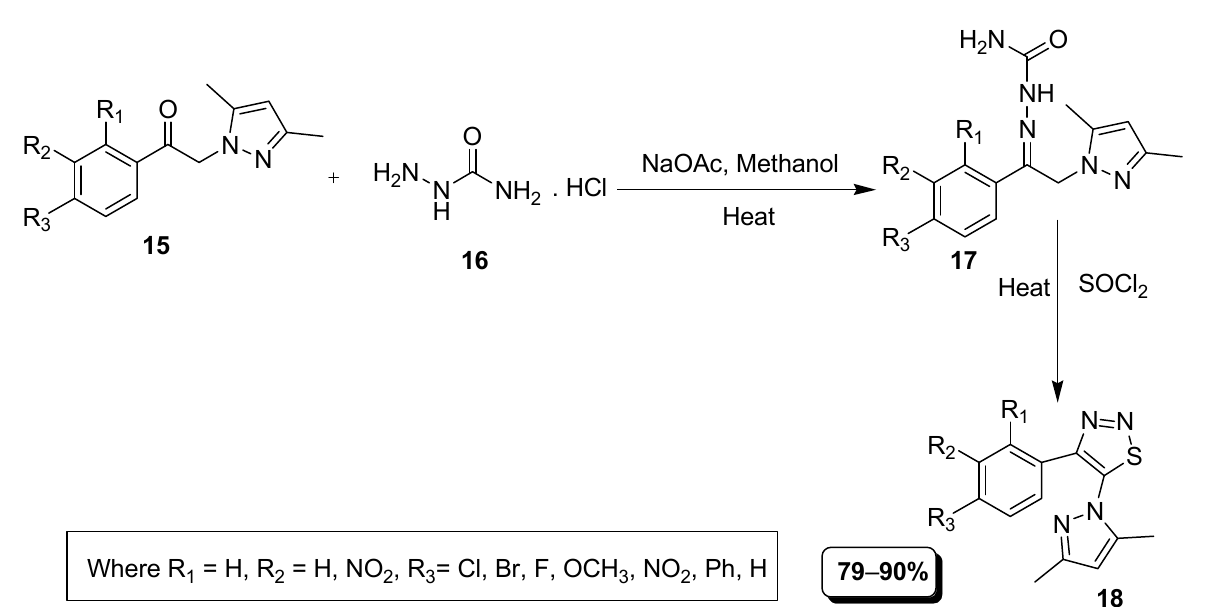
Scheme 1. Construction of pyrazole-based thiadiazoles 18 .